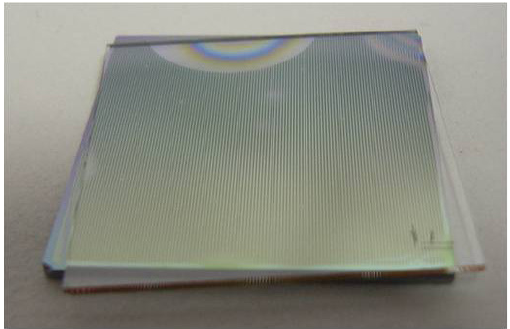
Figure 3. Ce:YIG on SOI sample fabricated by the surface activated direct bonding technique